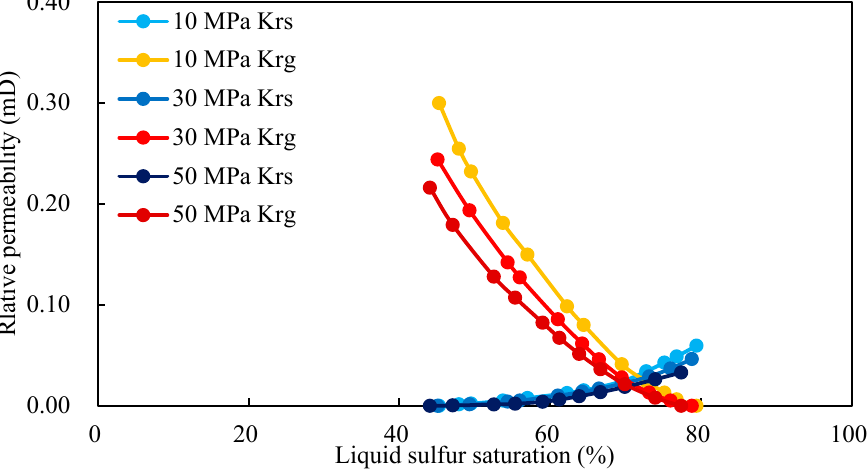
Figure 9. Gas–liquid sulfur relative permeability curves of Core 3 at different confining pressures.